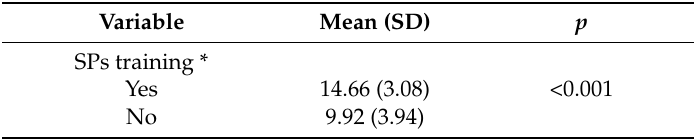
Table 2. Hypothesis testing for compliance with SPs (CSPS-It total score).